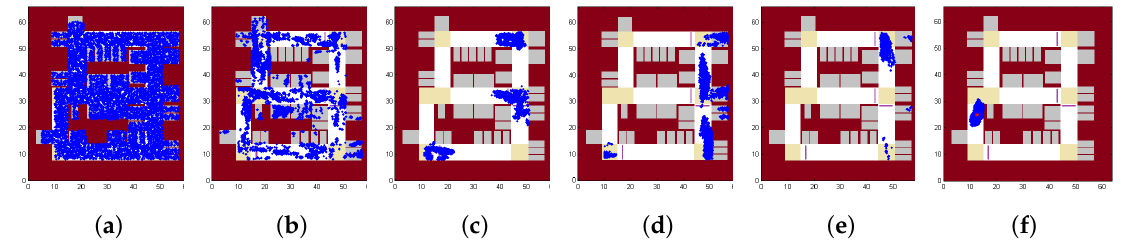
Figure 10. Particles over time without the initial position and the initial heading direction.